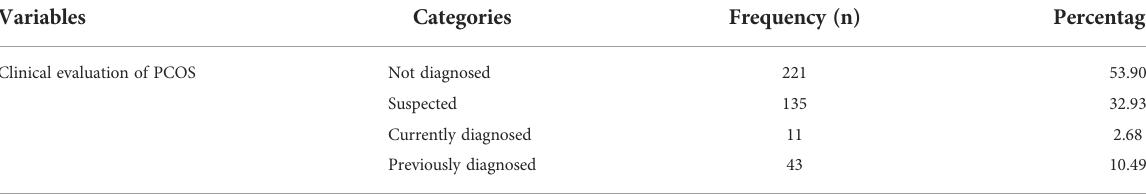
TABLE 2 Clinical evaluation of PCOS.